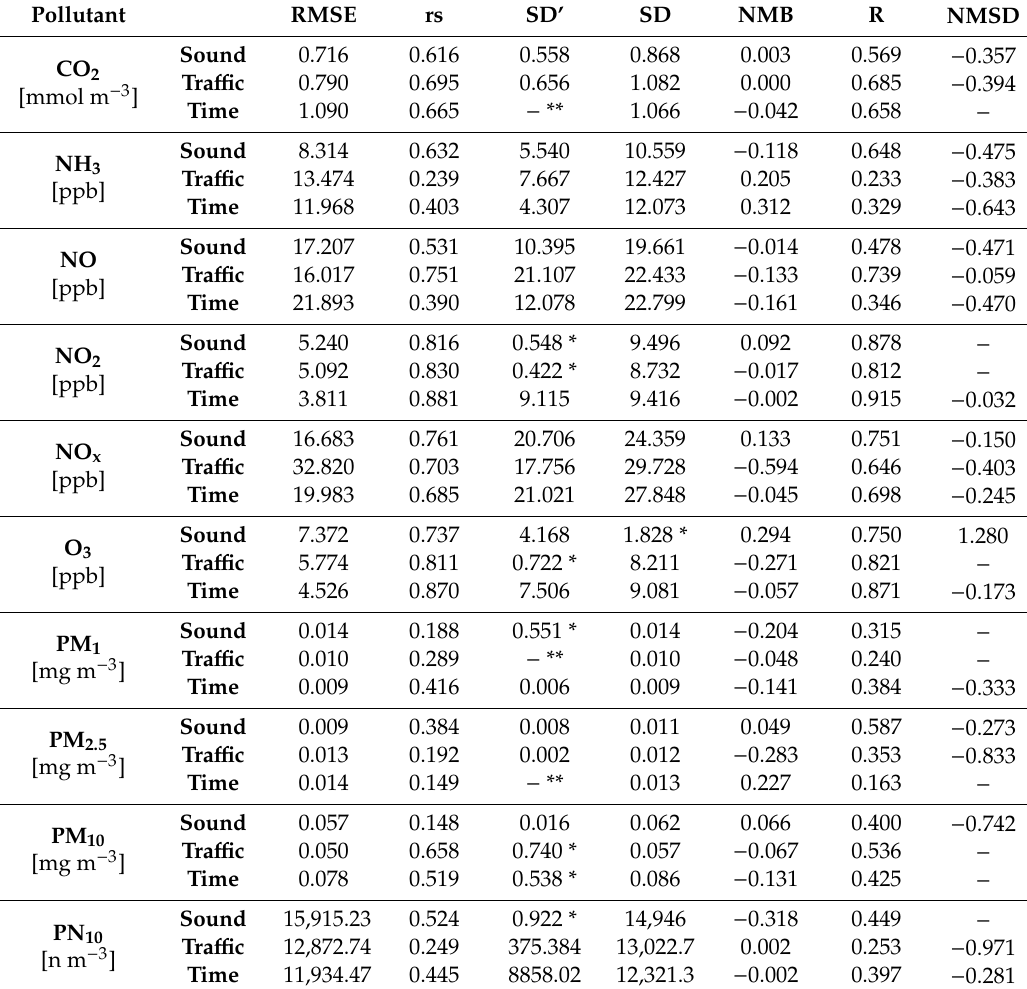
Table 5. Statistical parameters for evaluating the ANN